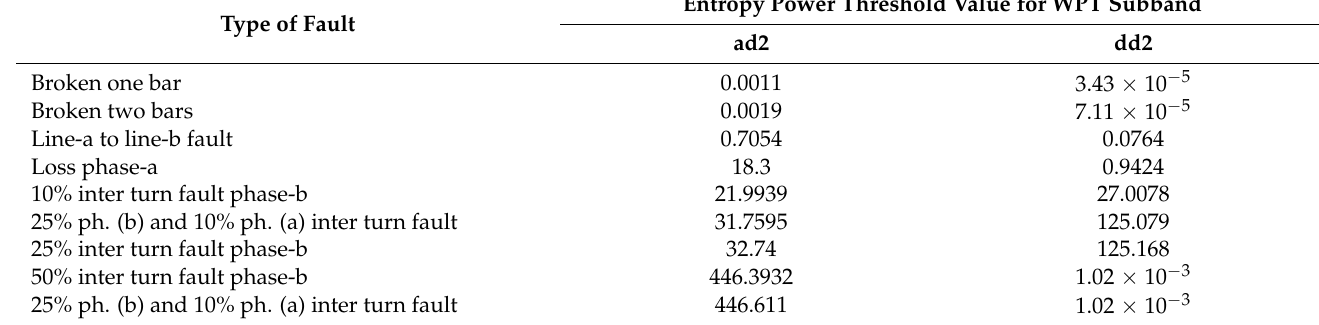
Table 4. Entropy power energy threshold values for diagnoses of different types of faults in an induction